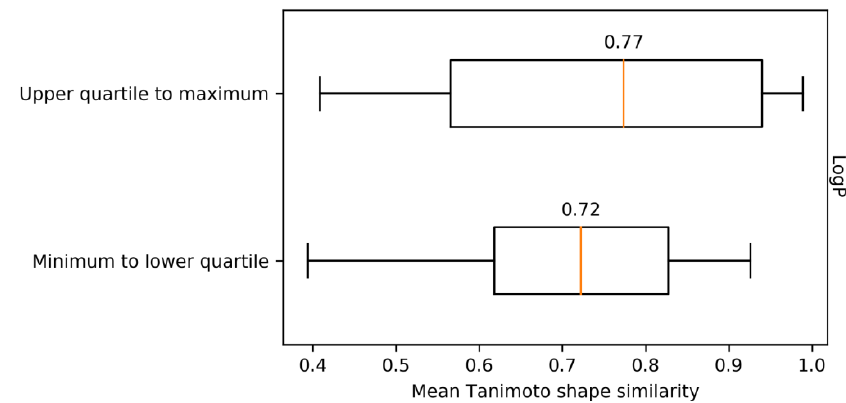
Figure 6. Shape similarity versus lipophilicity. For the 18 most lipophilic MCLs (25%; upper quartile to maximum LogP in Figure 5) and the 18 most hydrophilic MCLs (25%; minimum LogP to lower quartile), the distributions of mean pairwise shape similarity values are reported in boxplots. The orange line indicates the median value of each distribution.